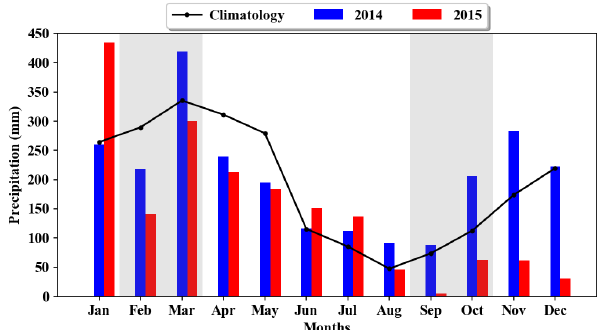
Figure 2. Distribution of accumulated monthly precipitation (mm) for the years 2014 and 2015 and the normal climatological